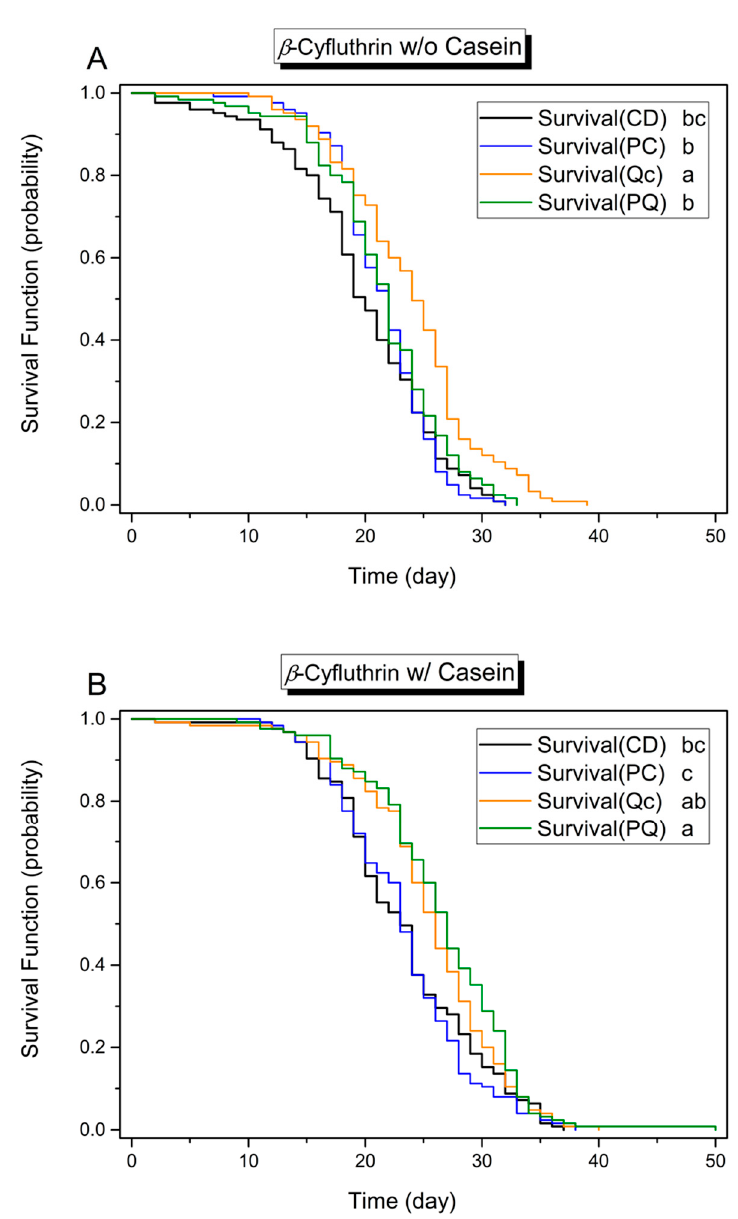
Figure 3. Kaplan–Meier plot of honey bee survival function on diets with different phytochemical supplements and β –cyfluthrin amendment. These diets were ( A ) protein-free or ( B ) protein-supplemented. CD, diet lacking phytochemicals; PC, diet containing 0.5 mM p- coumaric acid; Qc, diet containing 0.25 mM quercetin; PQ, diet containing 0.5 mM p- coumaric acid and 0.25 mM quercetin. ( n = 125 for each group.) Different lower-case letters indicate statistical differences between treatments (log-rank paired test, p < 0.0083 after Bonferroni correction).